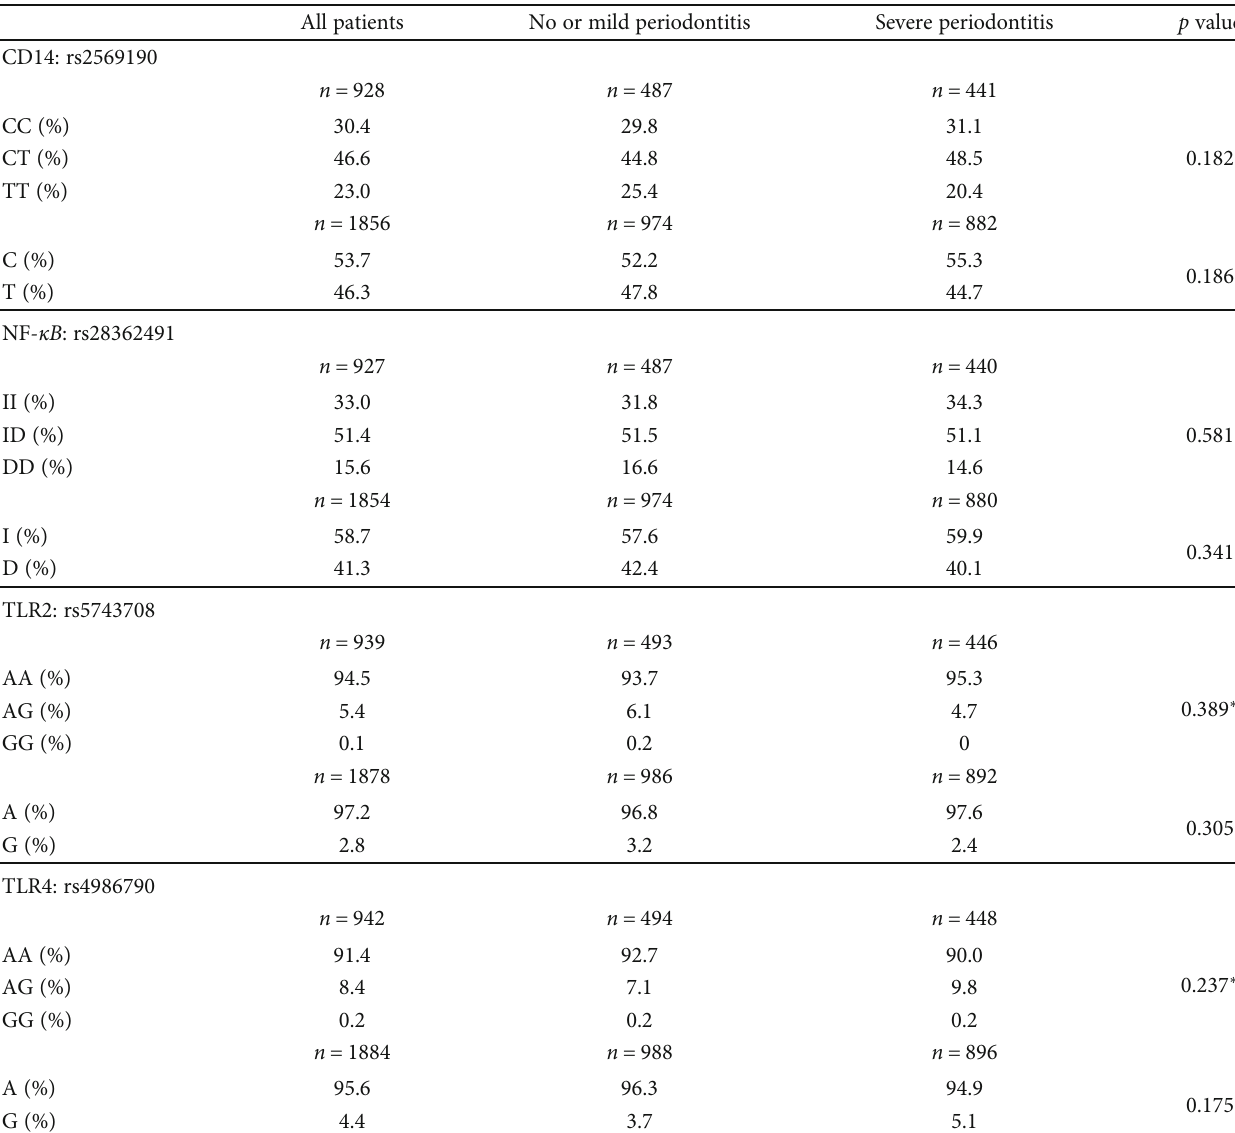
Table 3: Association of genotype and allele distribution of SNPs in CD14, NF- κ Β , TLR2, and TLR4 and periodontal disease severity. All patients No or mild periodontitis Severe